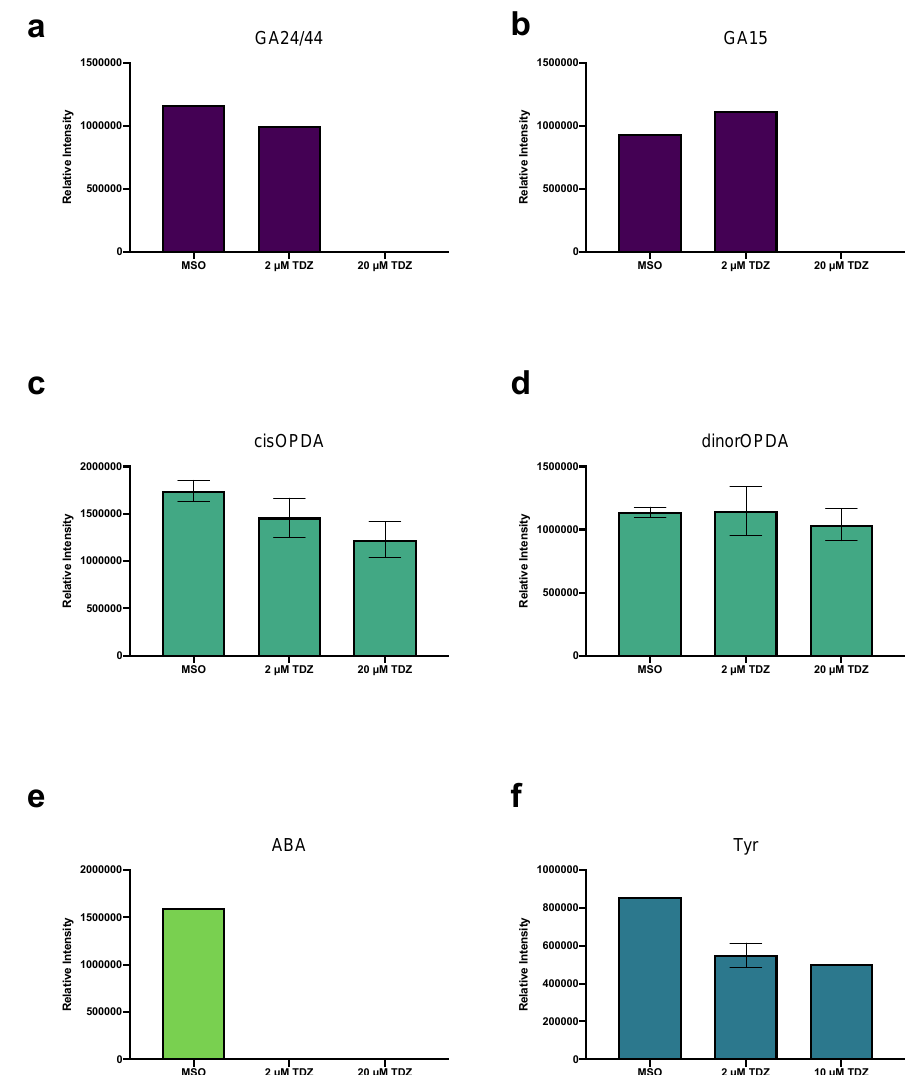
Figure 3. Effects of thidiazuron (TDZ) treatment on gibberellins (GA; ( a , b )), jasmonates (12-oxo-phytodienoic acid; OPDA; ( c , d )), abscisic acid (ABA; ( e )) and tyrosine (Tyr; ( f )) levels, identified by hormonomics analysis in African violet petioles. Bars represent mean, error bars span standard error margin. Where no error bars are displayed, the feature was present in only one replicate.